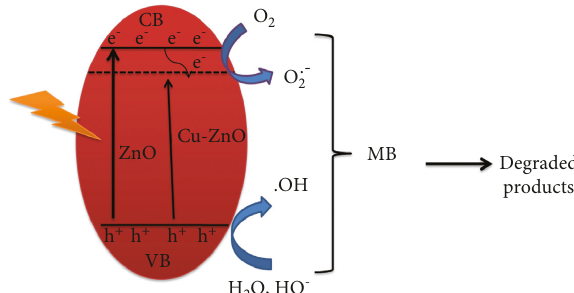
Figure 8: The possible degradation mechanism of MB dye with Cu- ZnO